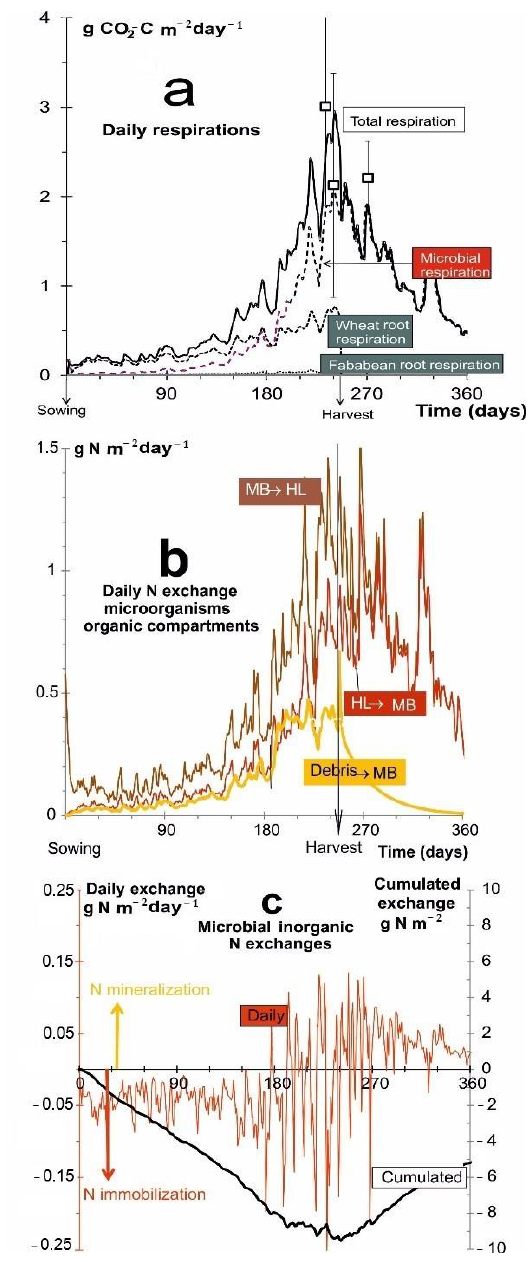
Figure 2. Example of flow predictions during intercropping: ( a ) bold black line: total daily respiration compared to field measurements (open square), red dashed line: microbial respiration, olive green dashed line: root respirations, ( b ) continuous exchanges of organic N with MB, ( c ) continuous exchange of inorganic N with